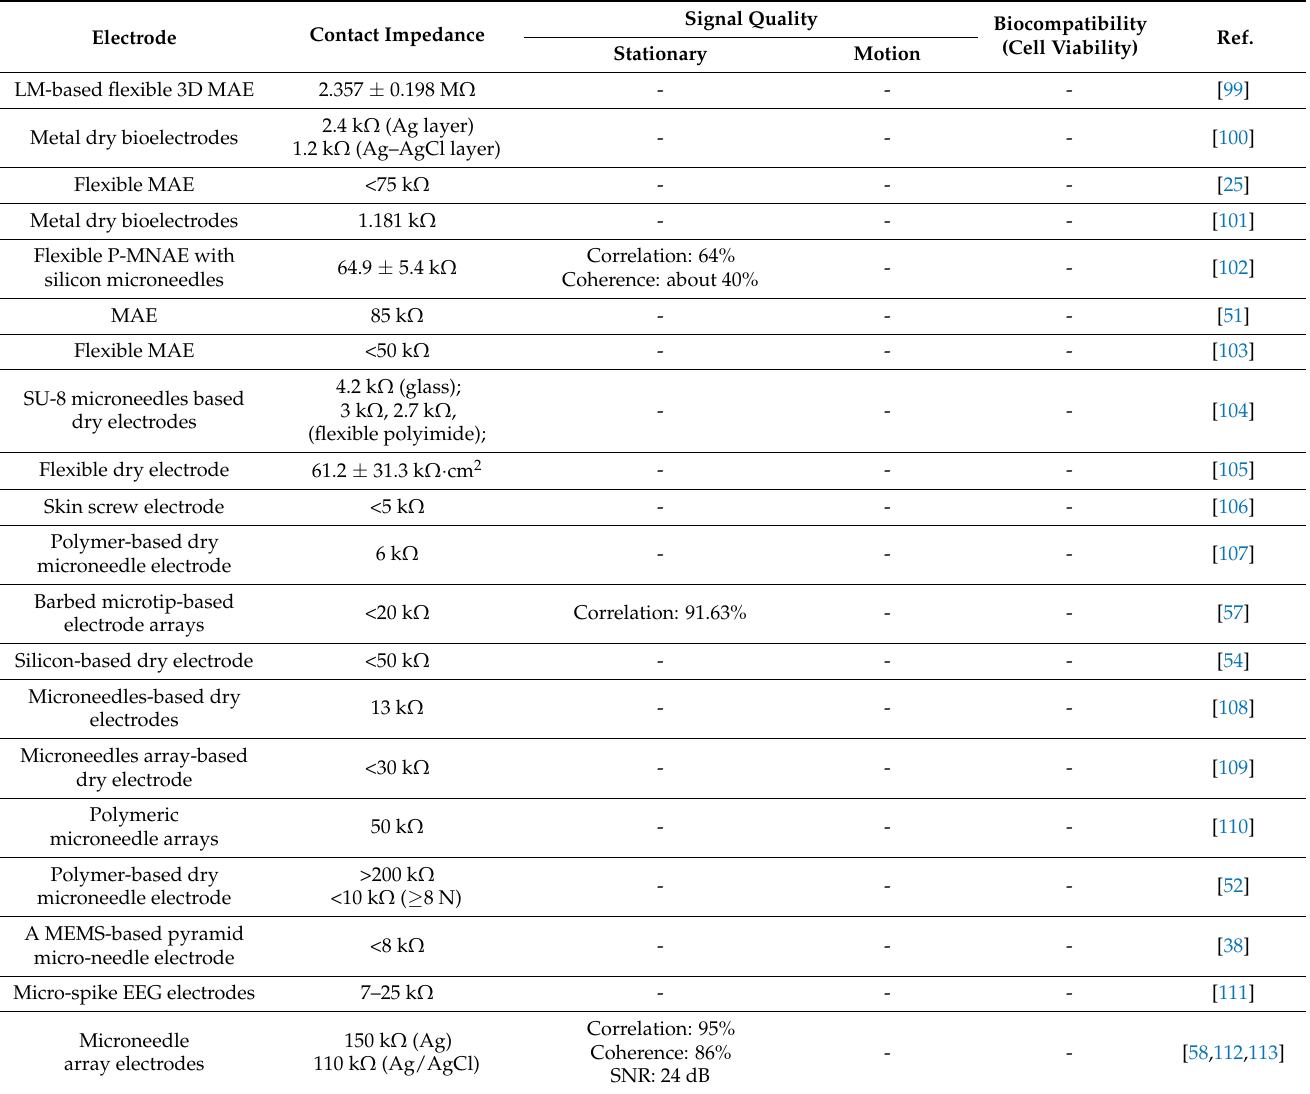
Table A5. Comparison of performance of the selected microneedle array EEG